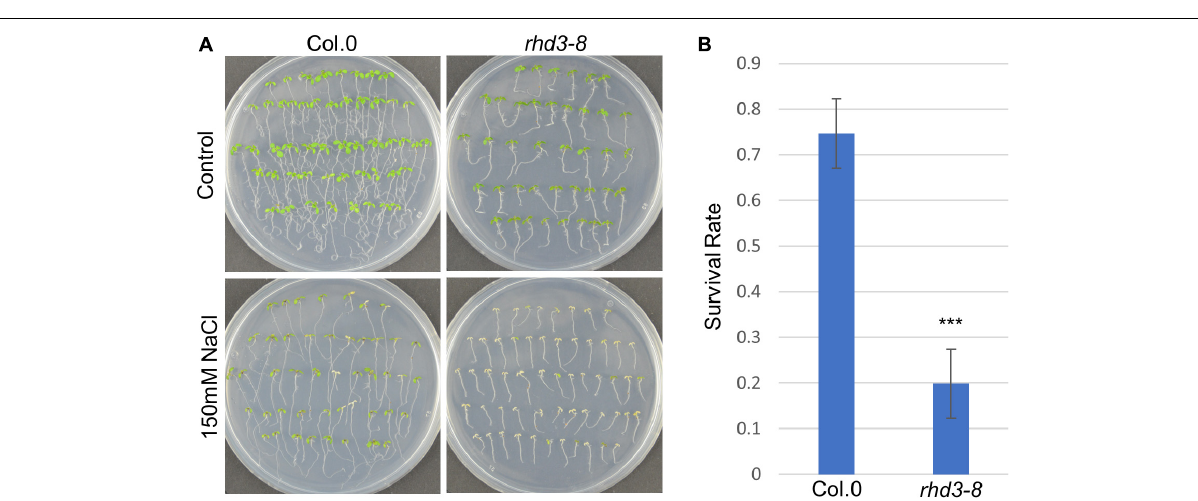
FIGURE 2 | rhd3 mutant is sensitive to salt stress. (A) Six-day old seedlings of WT and rhd3-8 grown on 1/2 MS for 5 days in the absence (control) and presence of 150 mM NaCl. (B) Quantification of survival rate of seedlings of WT ( n = 4, each time with 40–60 seedlings) and rhd3-8 ( n = 4, each time with 40–60 seedlings) grown on 1/2 MS with 150 mM NaCl. Error bars represent SD, *** represents significant difference ( P -value < 0.001, t